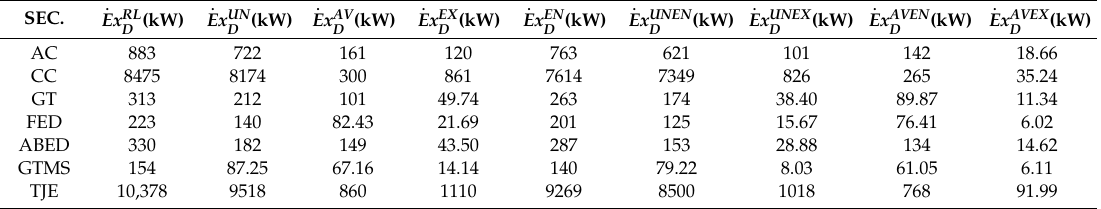
Table A5. Results for endogenous, exogenous, unavoidable and avoidable exergy demolition of TJE and sections in advanced exergy evaluation for the MIL process mode for H 2 utilization